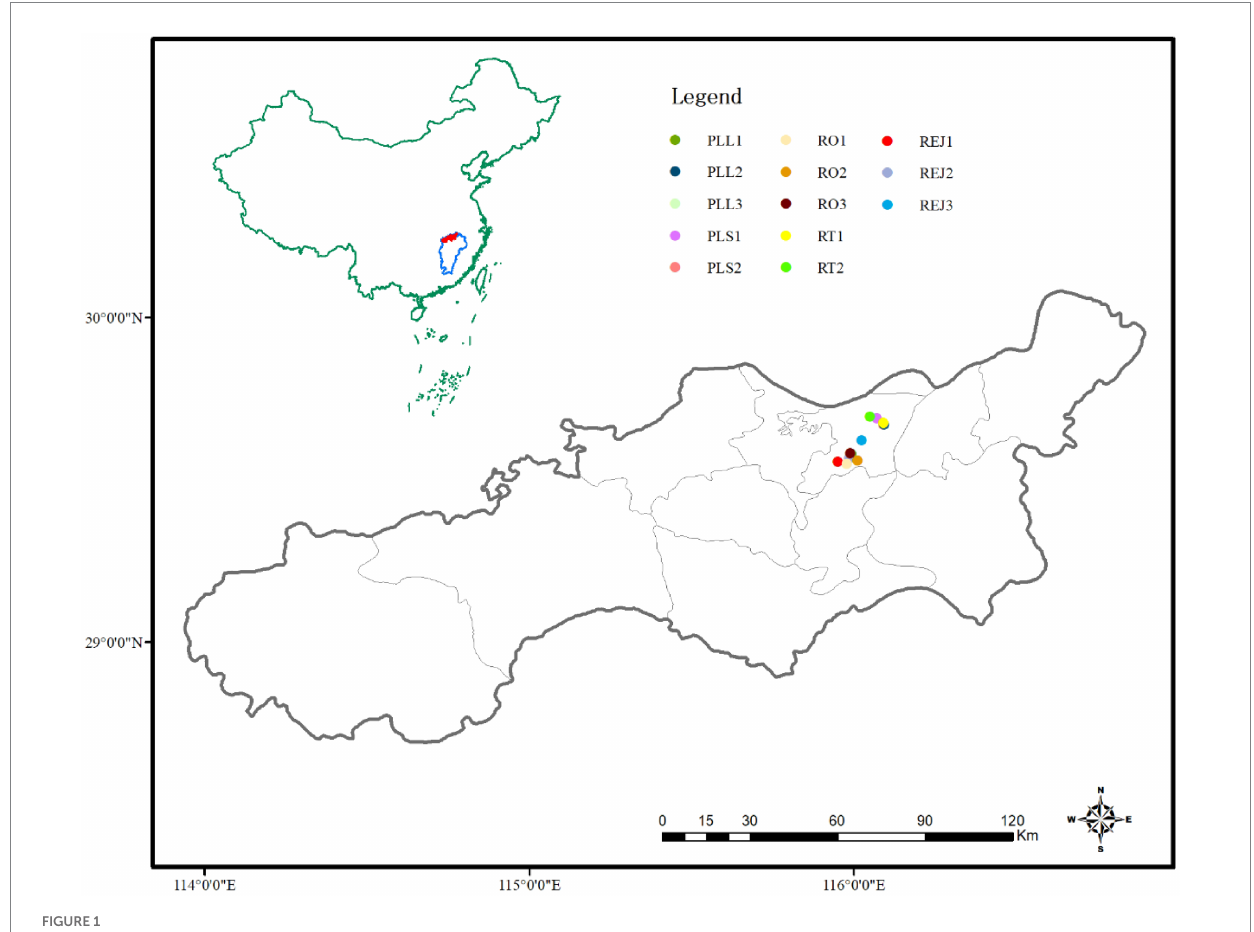
FIGURE 1 Location map of seed collection